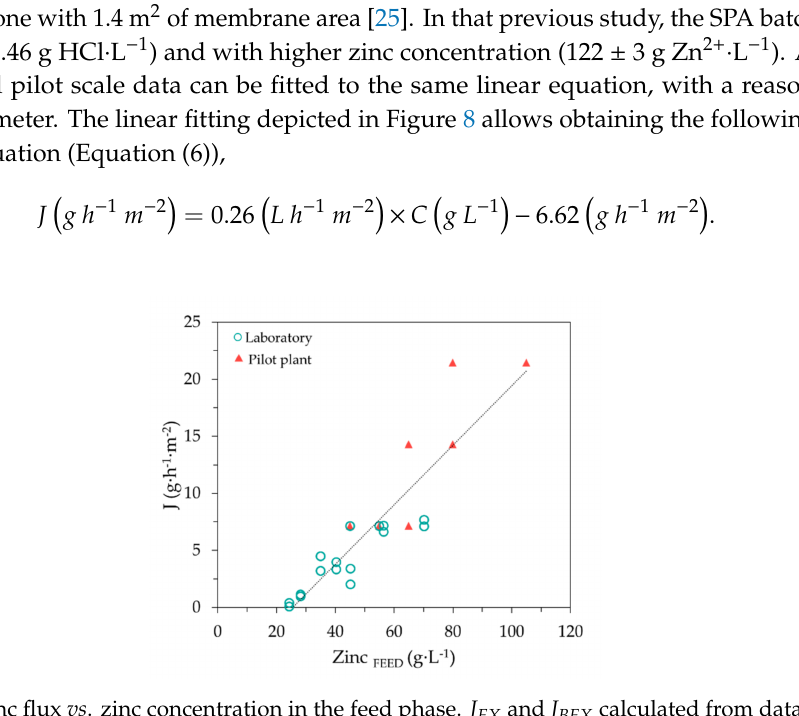
) reported by Laso et al. (cid:35)